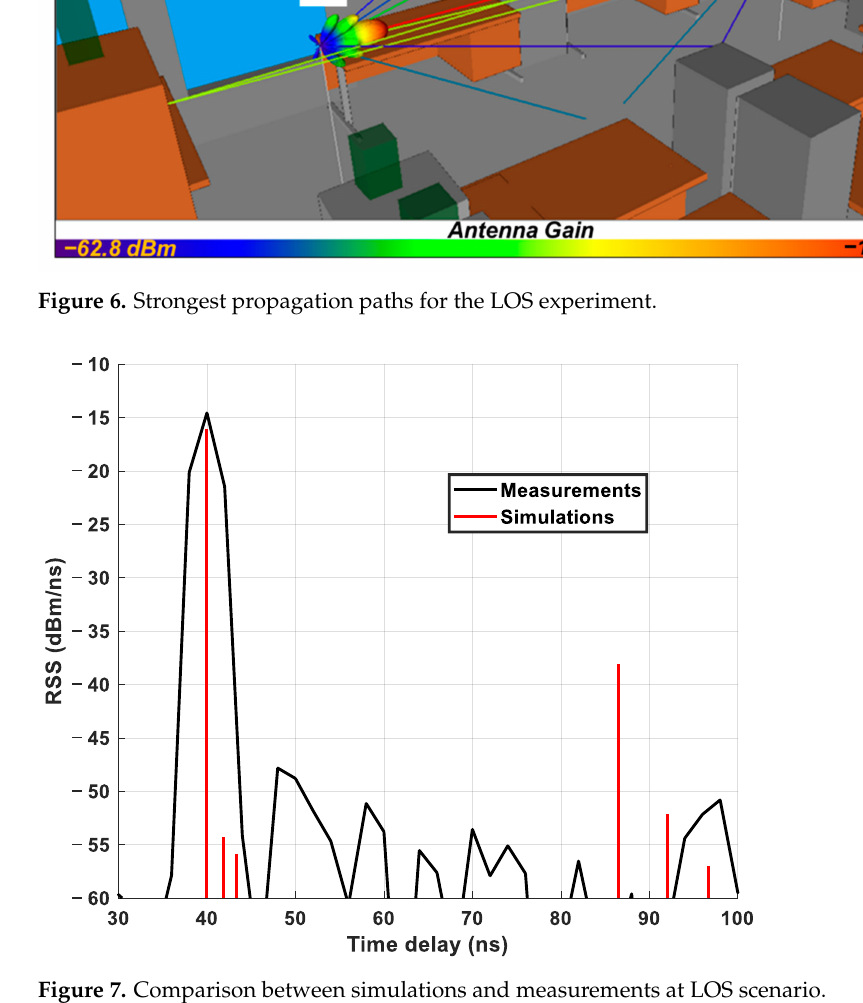
Figure 8. Reflection from the concrete wall (strongest path for all Rx1 points).